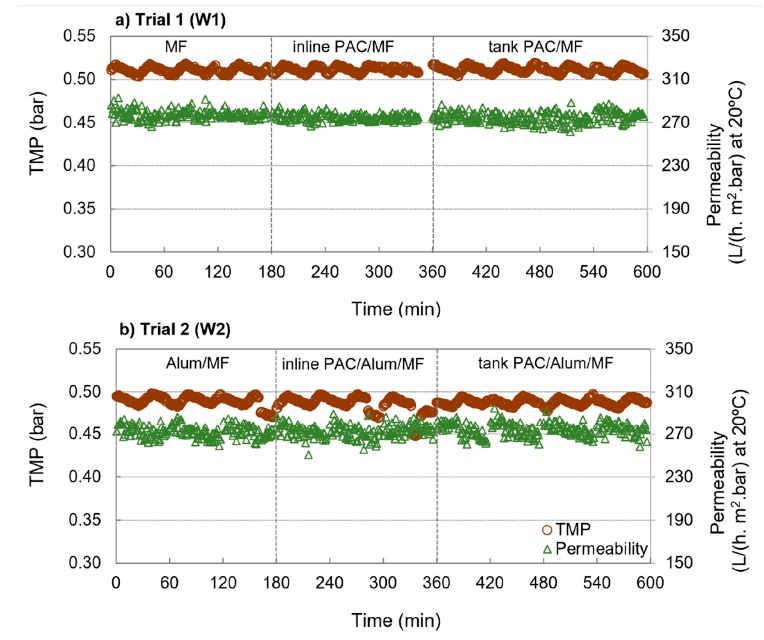
Figure 2. Transmembrane pressure (TMP) and membrane permeability during MF or PAC/MF filtration cycles with W1 ( a ) and during Alum/MF or PAC/Alum/MF filtration cycles with W2 ( b ); inline PAC dosing was tested in 3 filtration cycles and PAC dosing to contact tank in 4 filtration cycles.